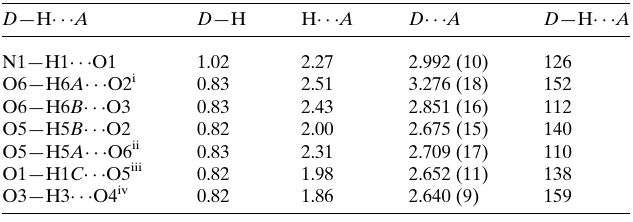
Table 1 Hydrogen-bond geometry (A˚ , (cid:3) ).